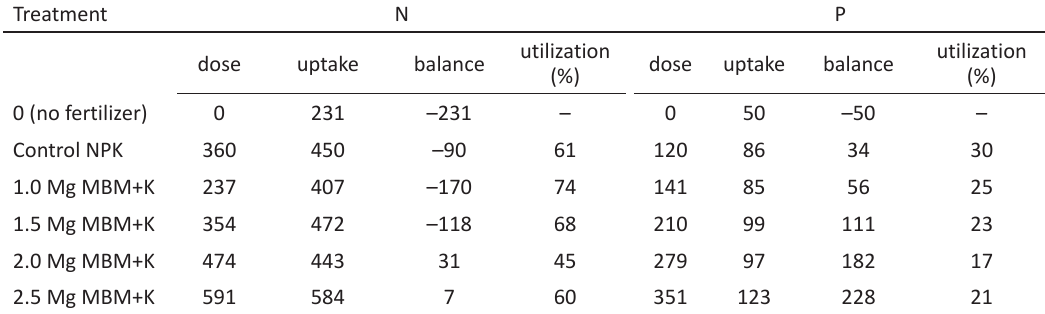
Table 5. Calculated cumulative nitrogen (N) and phosphorus (P) balance ( kg ha -1 ) for 2011–2013